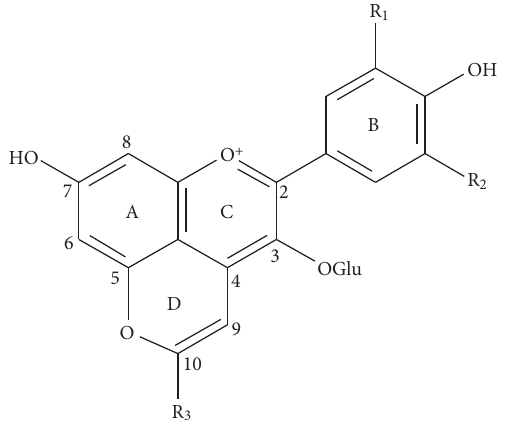
F 1: General structure of pyranoanthocyanins.